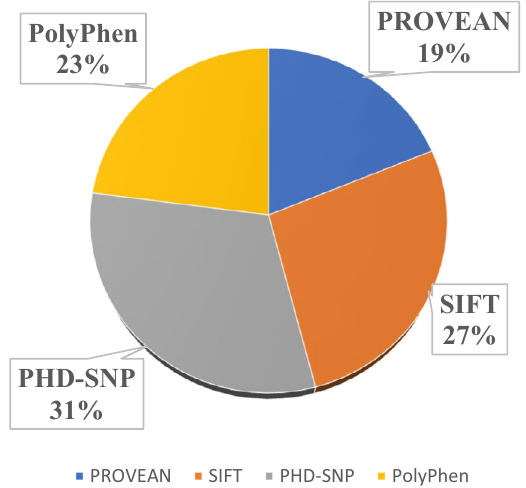
Figure 2. Percentage of potential damaging nsSNPs predicted through online computational tools.